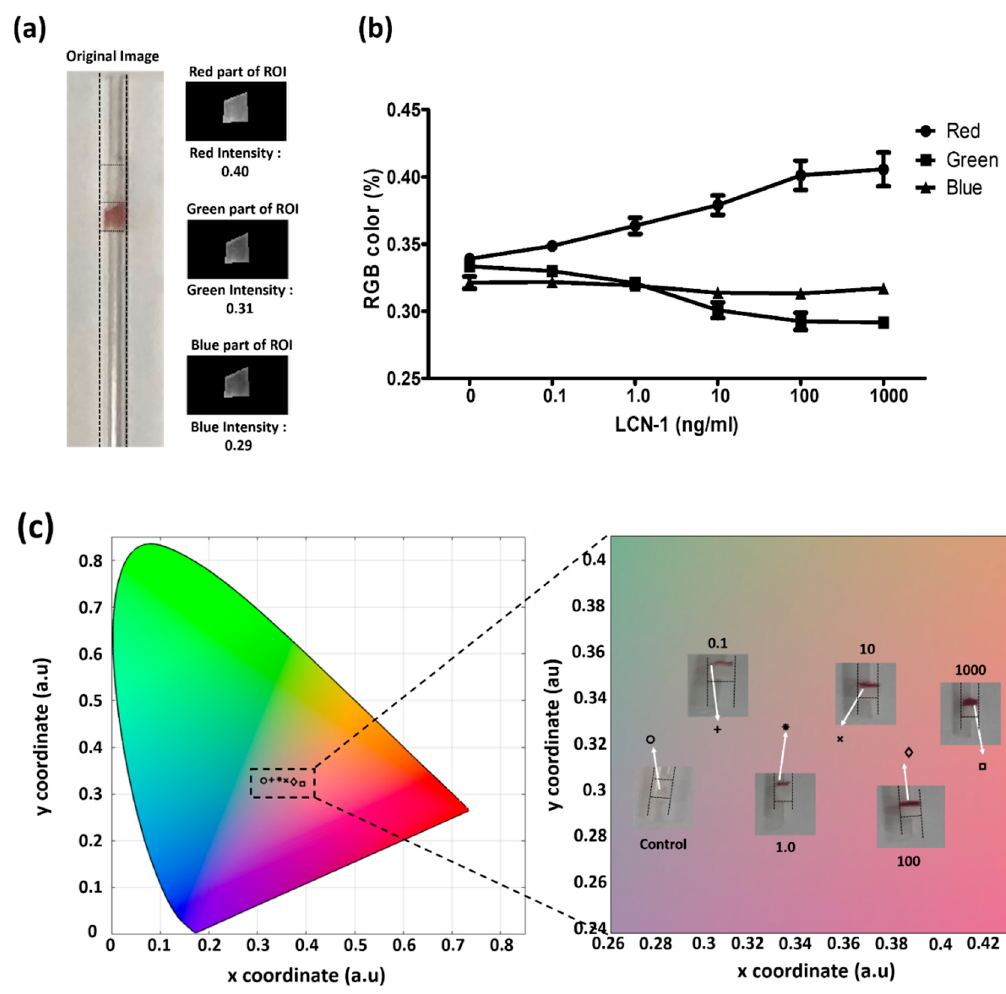
Figure 6. ( a ) MATLAB interface for image processing for color profile; ( b ) percentage of RGB of the sandwiched immunocomplex at different antigen concentrations; ( c ) CIE 1931 color profile of aggregated sandwiched immunocomplex for visualization with the naked eye. The unit of the numbers in the insets is ng/mL.